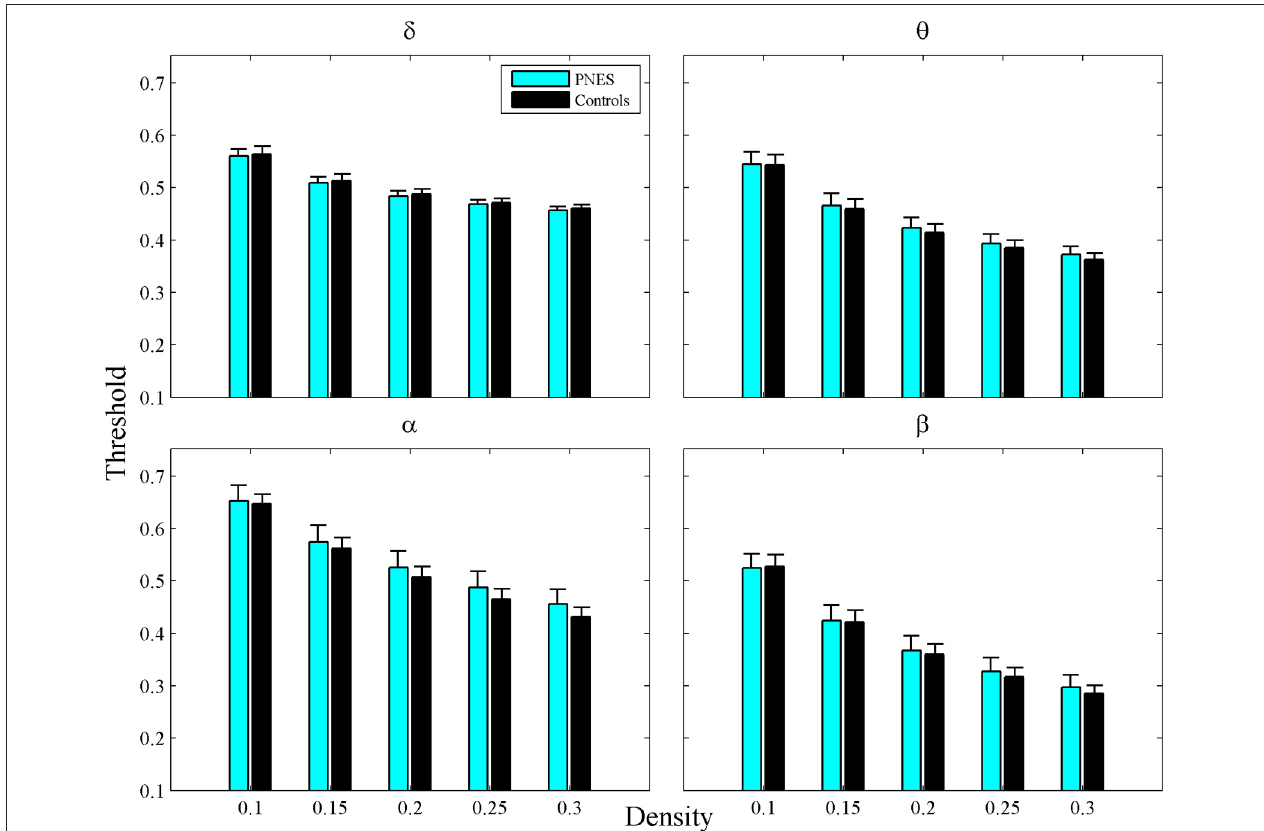
FIGURE A1 | Thresholds as a function of network density for PNES patients and controls. The plots show cross-correlation values used to obtain a network at each density by thresholding a subject’s weighted correlation matrix. Other designations are as Figure 2